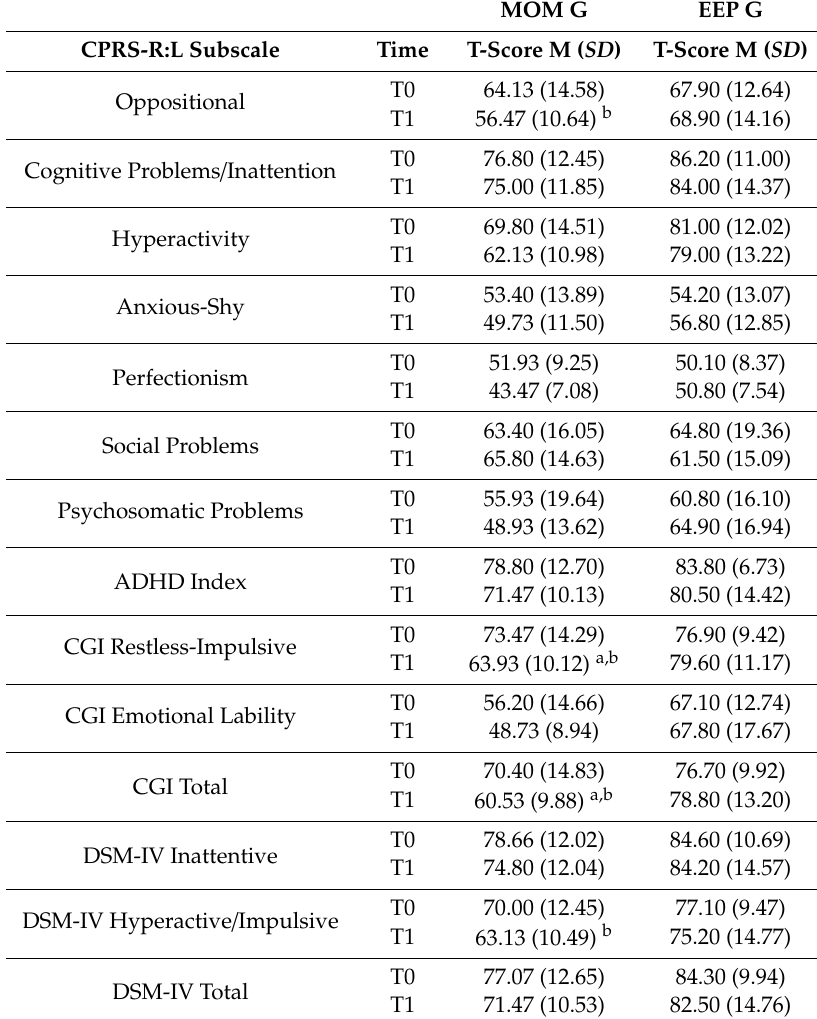
Table 2. Means and Standard Deviations of Conners’ Parent Rating Scales Long Version Revised subscales in the Mindfulness-Oriented Meditation Group and in the Emotion Education Program